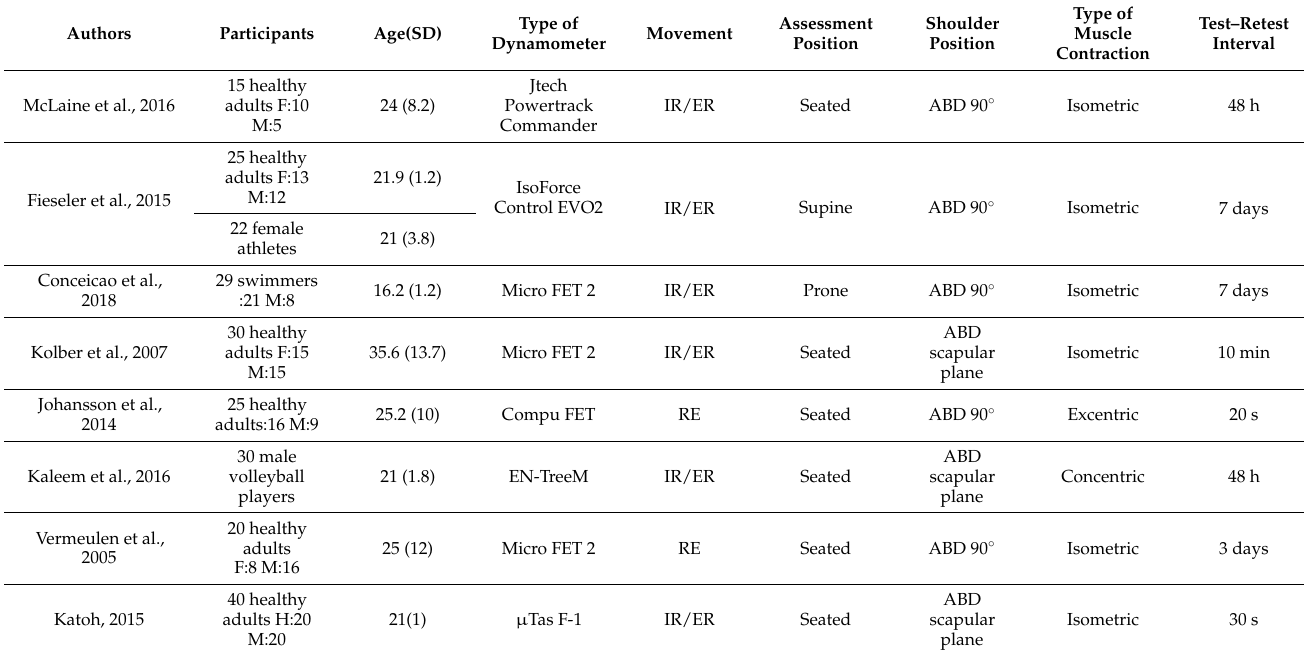
Figure 1. Flow chart of the manuscript selection process. Table 1 . Description of studies analyzing absolute reliability of HHDs .